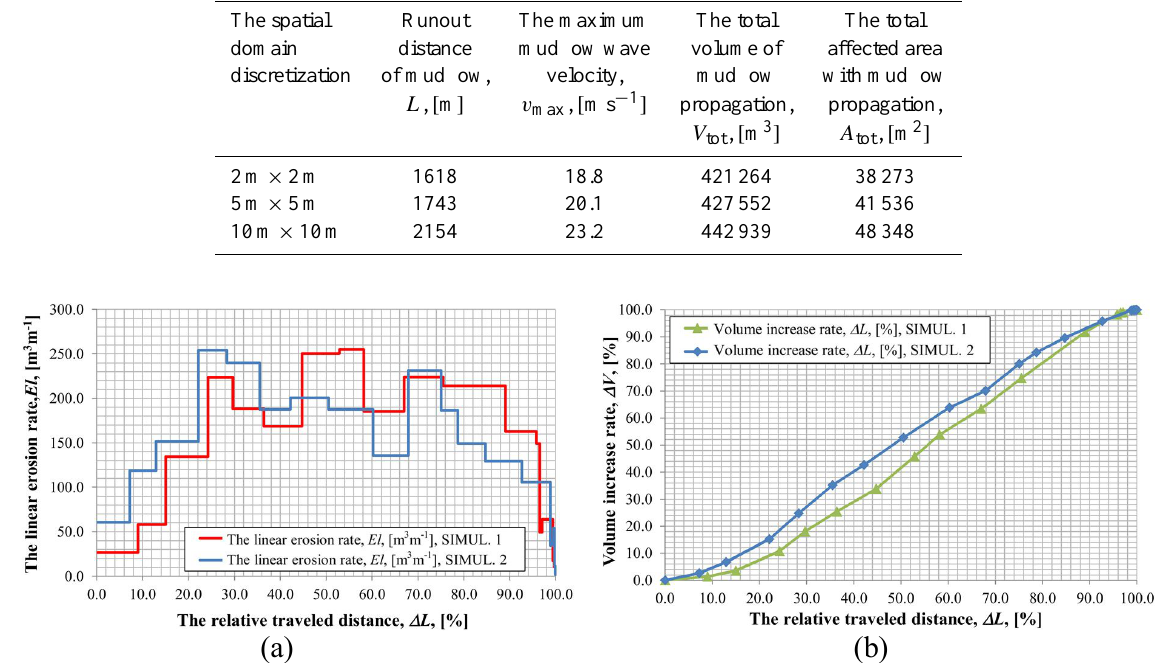
Figure 17. (a) Comparison of the linear erosion rate and the relative traveled distance and (b) comparison of the volume increase rate and the relative traveled distance for the 1908 Grohovo mudflow